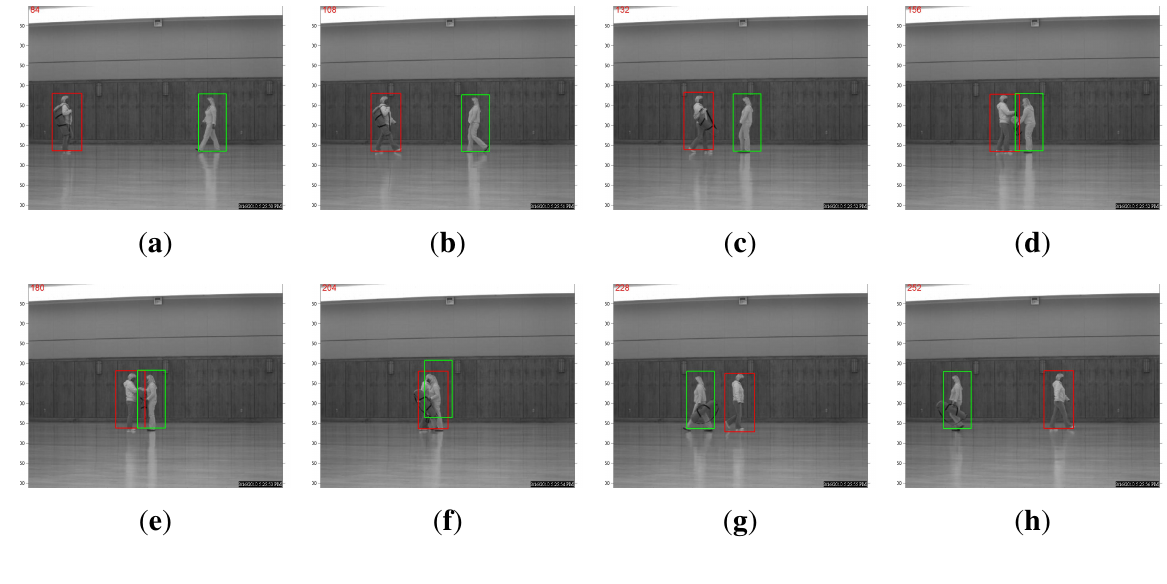
Figure 4. Joint tracking-and-recognition is capable of persistently tracking both pedestrians regardless of the occlusion and bad exchange (both red and green boxes are correctly associated with the correct